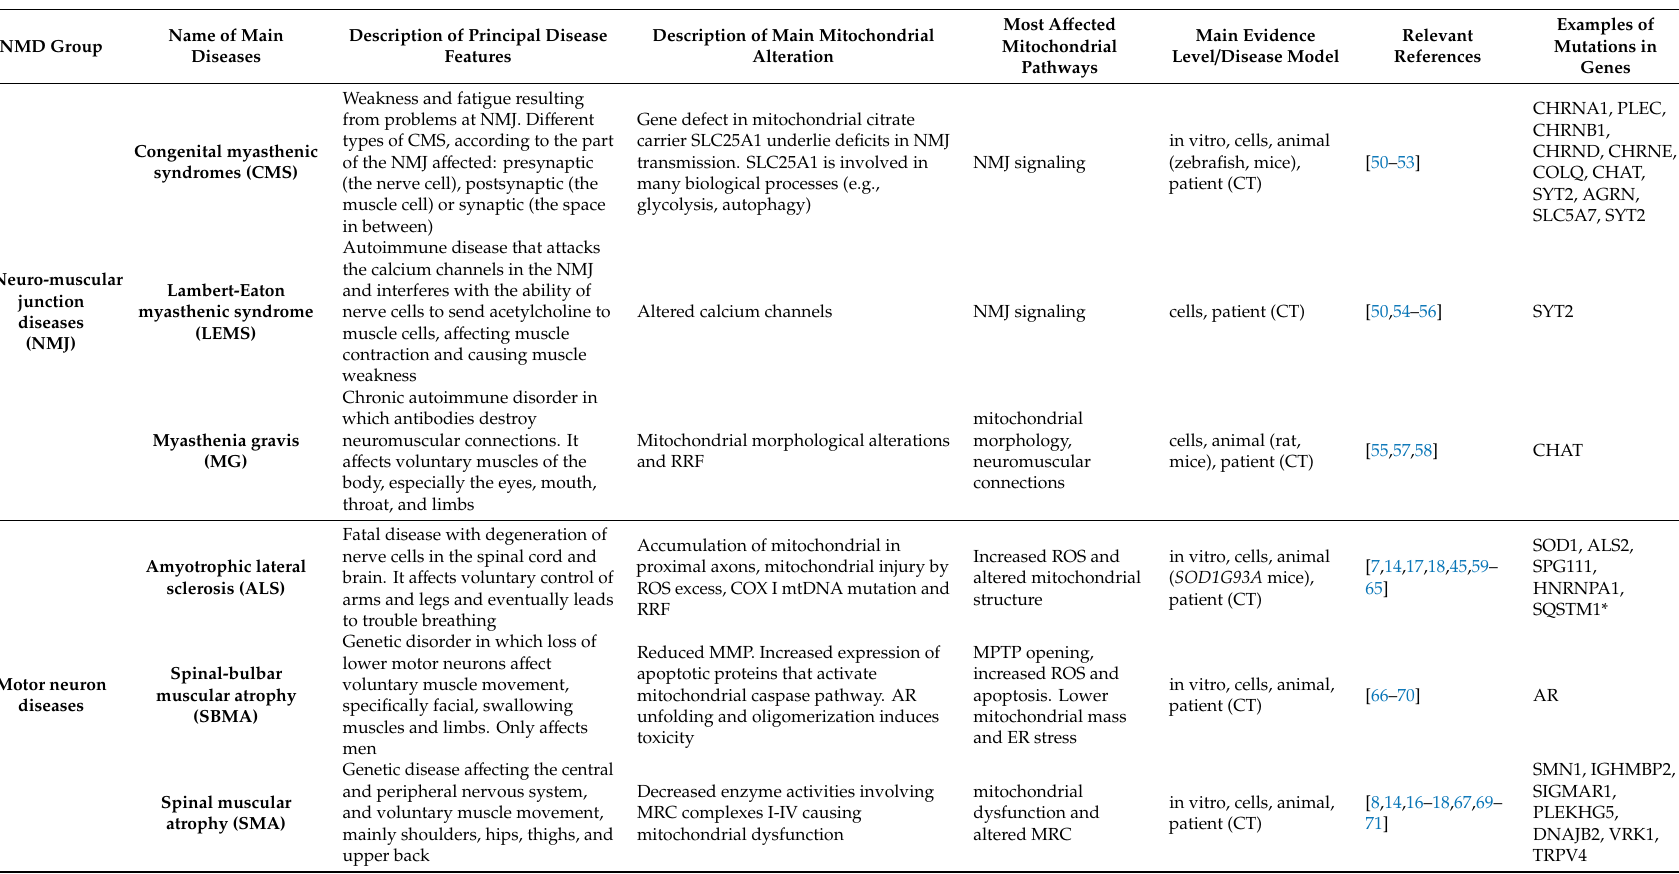
Table 3. Examples of studies reporting altered mitochondrial functions in Neuromuscular Junction Diseases (NMJ) and Motor Neuron